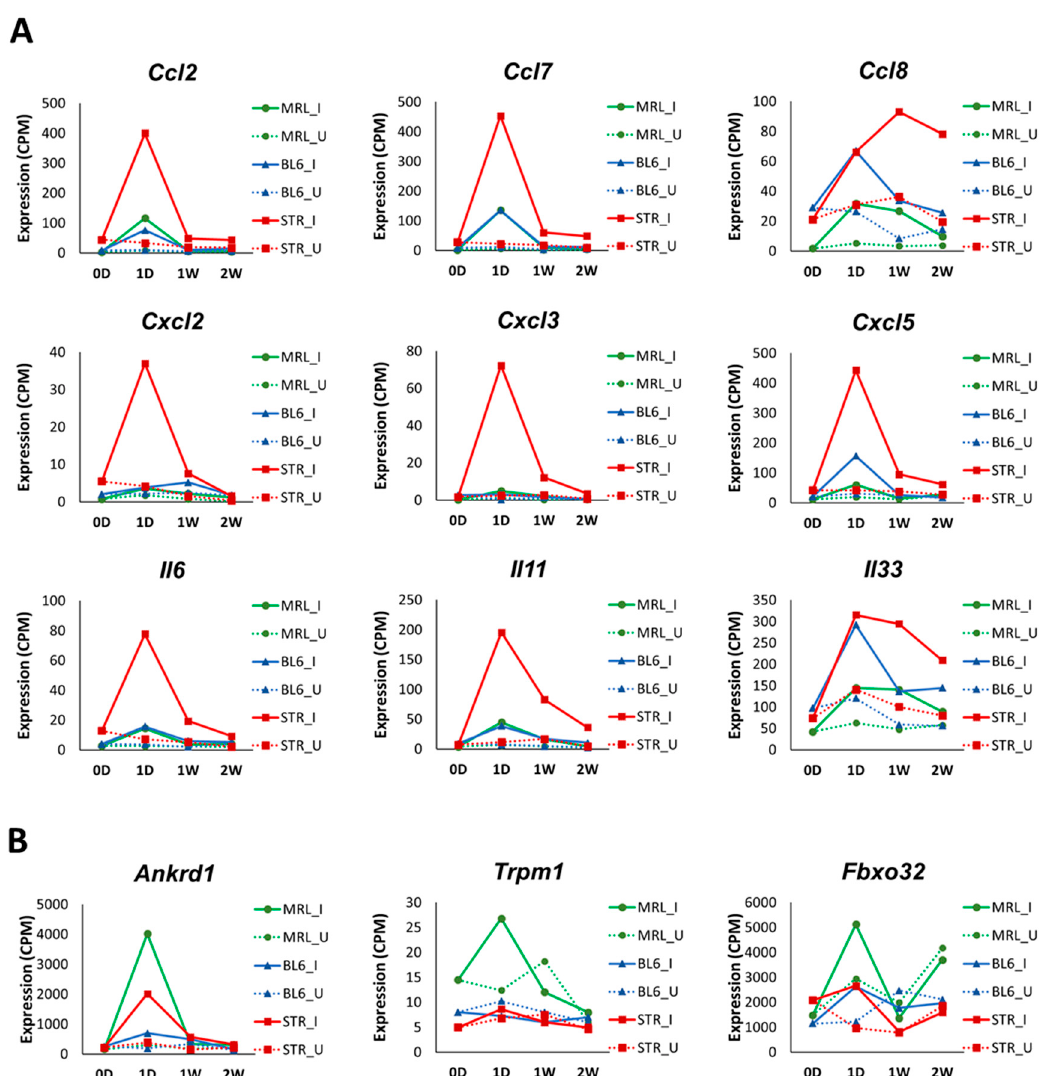
Figure 4. Expression profiles of inflammatory cytokines. ( A ) Selected inflammatory cytokines with significantly higher expression in injured STR/ort (STR) compared to C57BL/6J (BL6) and MRL/MpJ (MRL) at 1-day post-injury. ( B ) Selected injury-induced genes with significantly higher expression in injured MRL compared to the other two strains at 1-day post-injury. I: Injured; U: Uninjured; 0D: 0-day; 1D: 1-day; 1W: 1-week; 2W: 2 ‐ weeks.